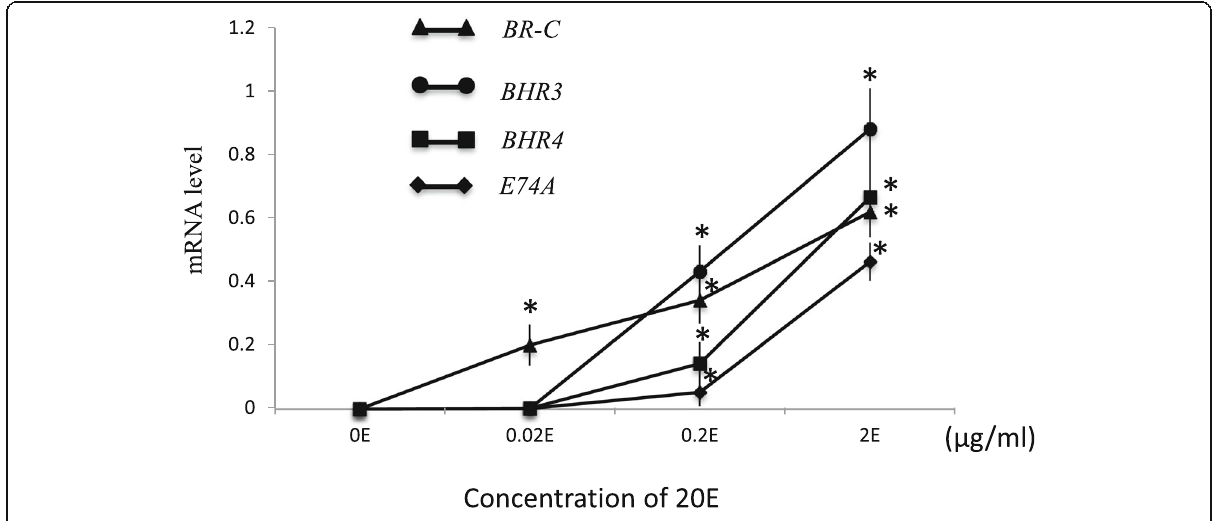
Fig. 3 Induction of transcripts of ERTFs by different concentration of 20E. V4 wing discs were incubated for the indicated time in a medium containing indicated concentration of 20E. RNA was extracted from wing discs and reverse-transcribed to cDNA for use in qRT-PCR. Values were first normalized to rpl and then plotted relative to the 0h value for each panel. Each datum was calculated from three independent experiments. The result is expressed as the mean ± S. E. M. Asterisks indicate p < 0.05 significance by the Student ’ s t test. Level of mRNA of the ecdysone